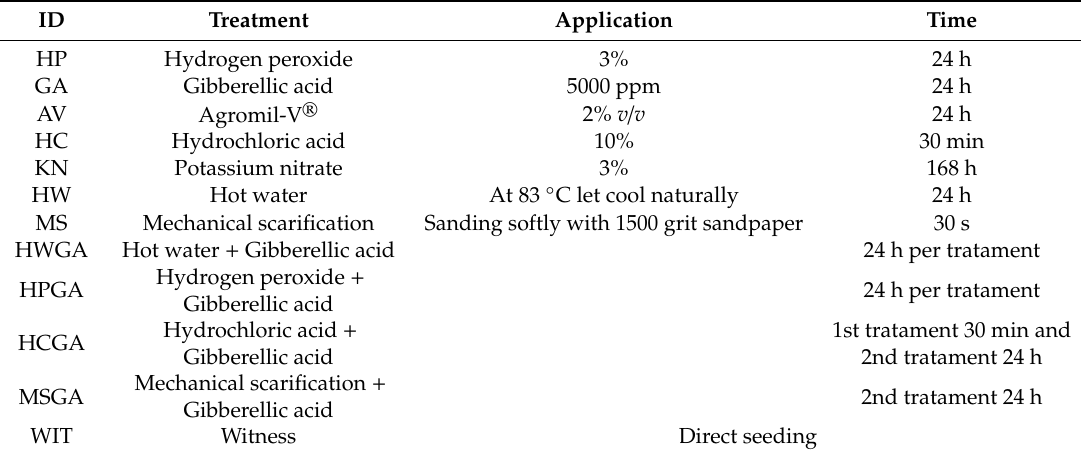
Table 2. Treatments used to evaluate the germination response of piquin pepper